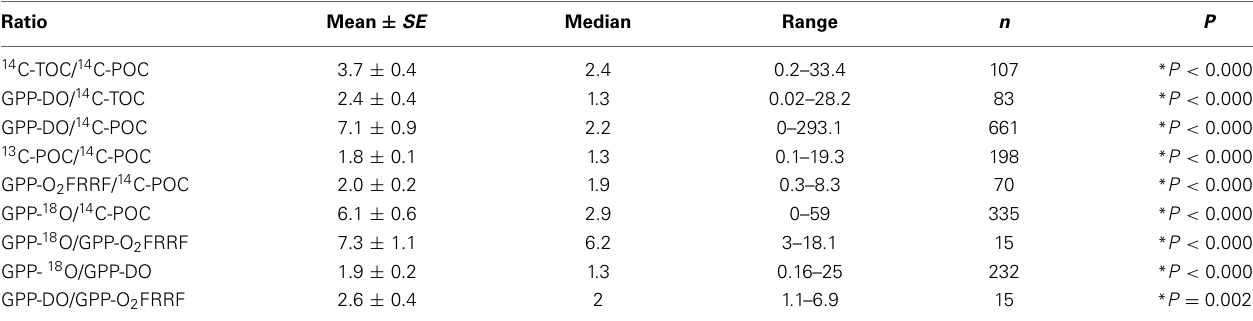
Table 3 | Mean ( ± SE ), median, range (minimum–maximum), and number of observations ( n ) of the primary production ratio between different methods used concurrently, and the probability P , statistics t , and degrees of freedom df of the t -test testing if primary production rates measured by two methods concurrently are significantly different ( * represents the significant